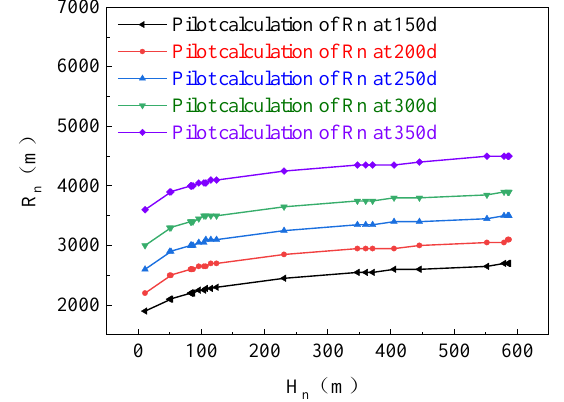
Figure 7. Variation pattern of radius of influence Rn for each segment.